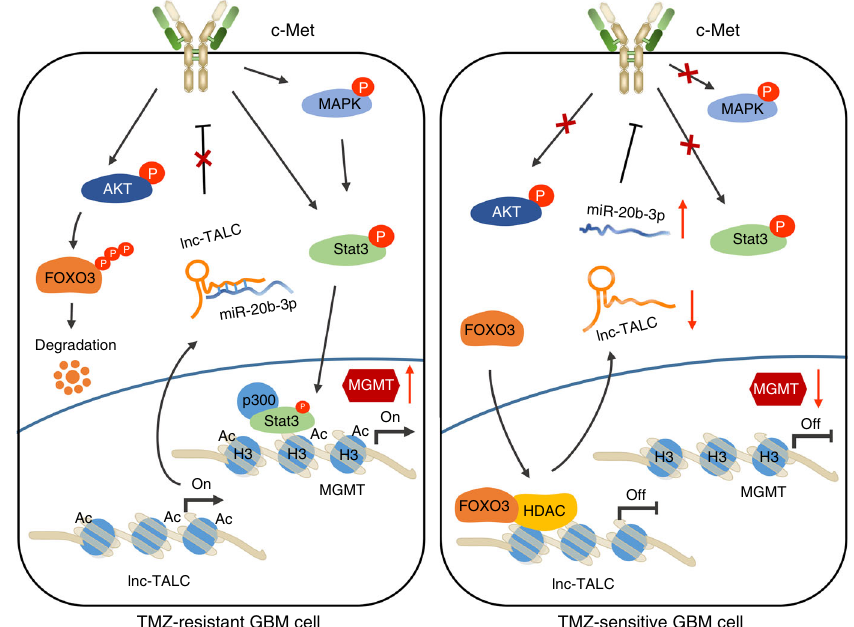
Fig. 9 The mechanistic scheme of lncRNA lnc-TALC in GBM. The mechanistic scheme of lncRNA lnc-TALC promoting MGMT expression via regulating the c-Met signaling pathway as a competitive